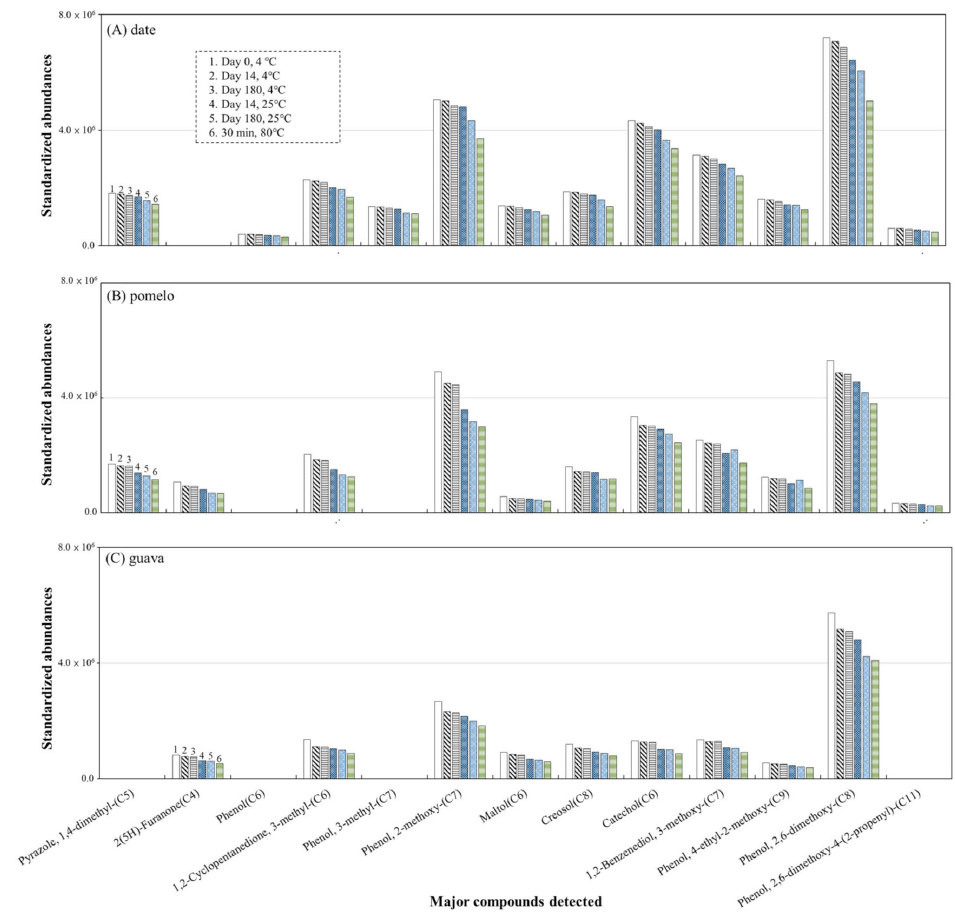
Figure 5. Plot of standardized abundances of the major ingredients in each SCLs: date ( A ), pomelo ( B ), and guava ( C